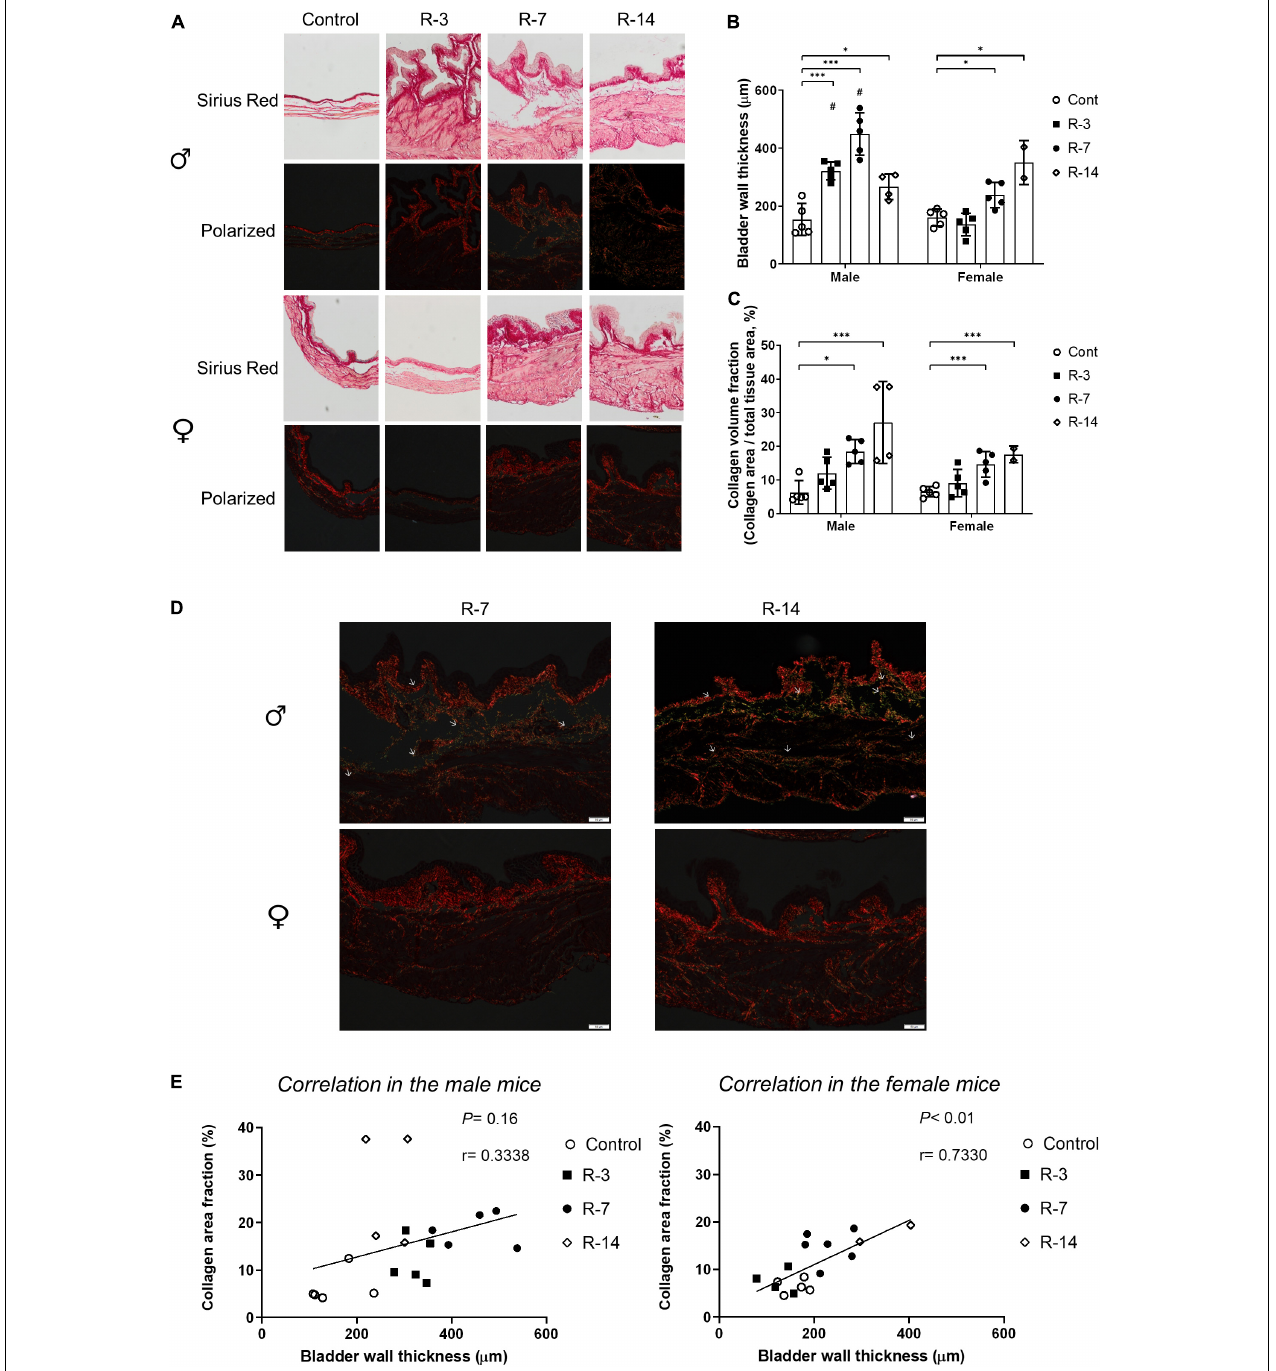
FIGURE 1 | Bladder wall changes after release of 24 h total bladder outlet obstruction detected by Sirius Red staining. (A) It illustrated the collagen deposition in the bladder wall. By way of polarized filter, the collagen fiber was bright red/green on the dark background ( n = 4 in the male R-14 group, n = 2 in the female R-14 group, and n = 5 in other groups). (B) Increased bladder wall thickness was shown in male mice at 3, 7, and 14 days post release, but only 7 and 14 days post release in female mice. The bladder walls in the R-3 and R-7 groups in the male mice were thicker compared with those in the female mice. (C) Increased collagen area fraction in the smooth muscle layer was shown in the R-7 and R-14 groups in both genders. (D) Deposition of collagen I (indicated in red) was pronounced in the suburothelium and smooth muscle layers in both genders. Collagen III deposition (indicated in green) was more pronounced in the smooth muscle layer in the male 7 and 14 days post release. There was nearly no collagen III deposition in the female 7 or 14 days post release (original magnifications 10 × ). Arrows show localization of collagen III. (E) The increased collagen area fraction did not correlate with the bladder wall thickness in the male mice, while significant correlation was shown in the female mice. Male, Female. Data are presented as means ± SD. ∗ P < 0.05 and ∗∗∗ P < 0.01. # P < 0.05 compared between genders with the corresponding ♂ ♀